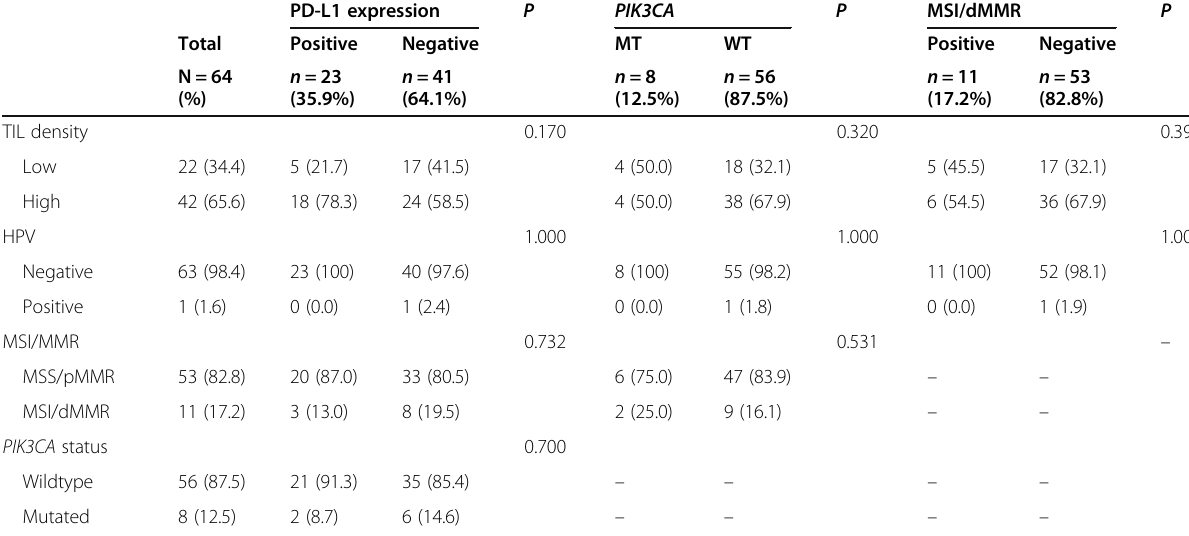
Table 2 Clinicopathologic correlations of PD-L1 expression, PIK3CA mutation, and MSI/dMMR status (Continued)